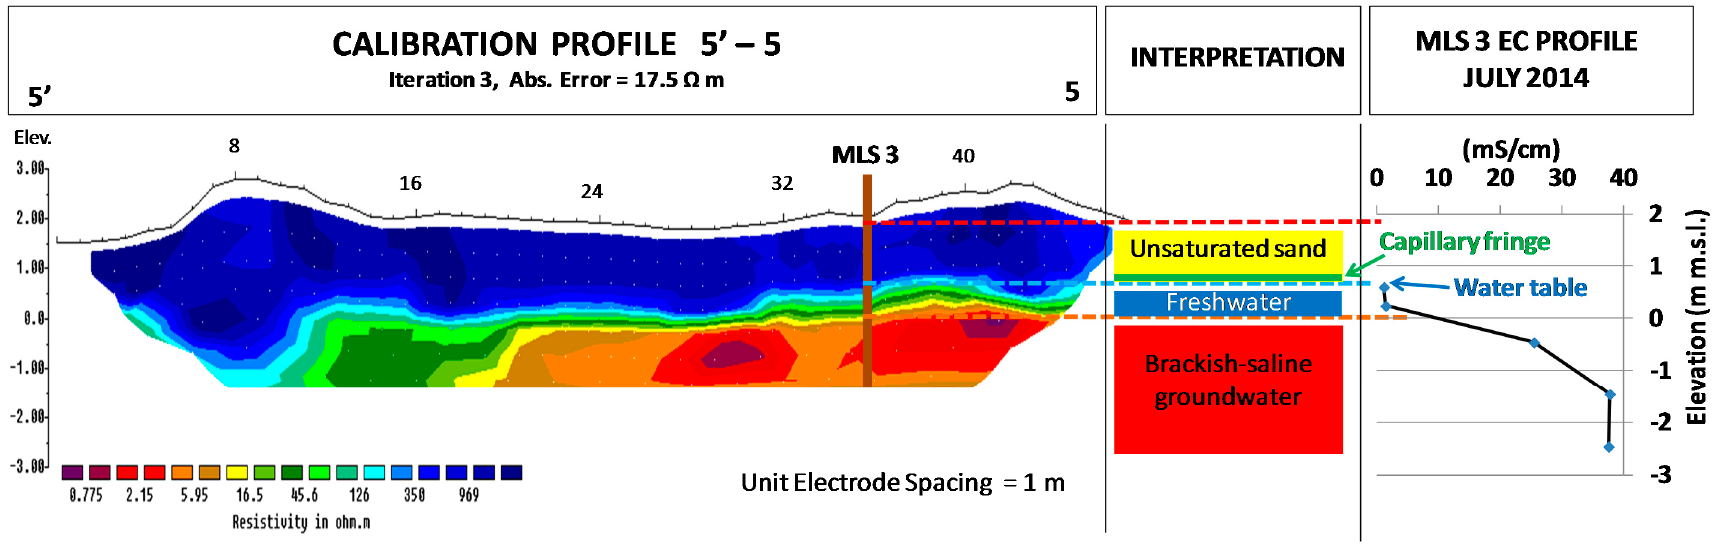
Figure 4. Inverted resistivity profile 5’-5. On the right side, the vertical EC profile of groundwater at MLS3 (water table depth (WTD) is shown by the green dashed line) and interpretation of the resistivity classes.